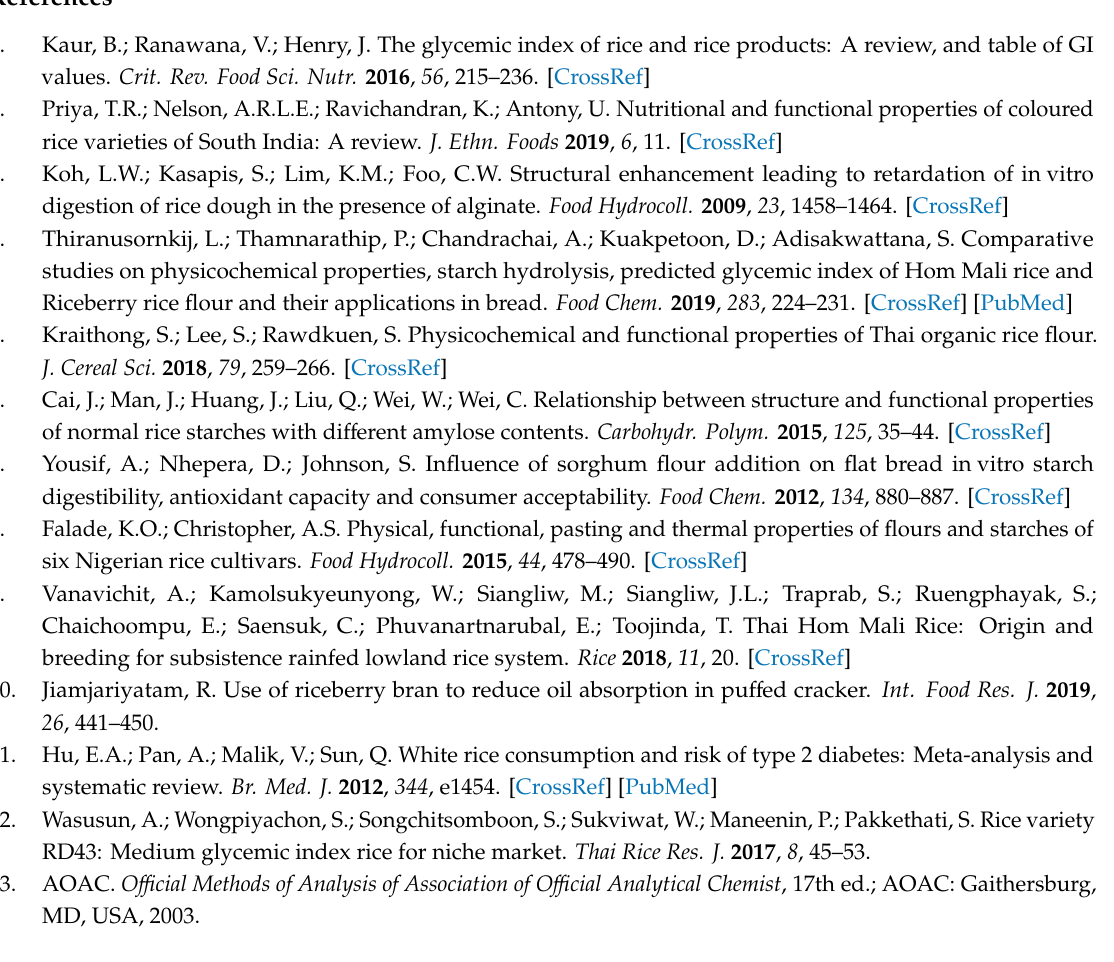
Figure S1: Di ff erential scanning calorimetry (DSC) curves of ( a ) Hom Mali and ( b ) RD43 rice